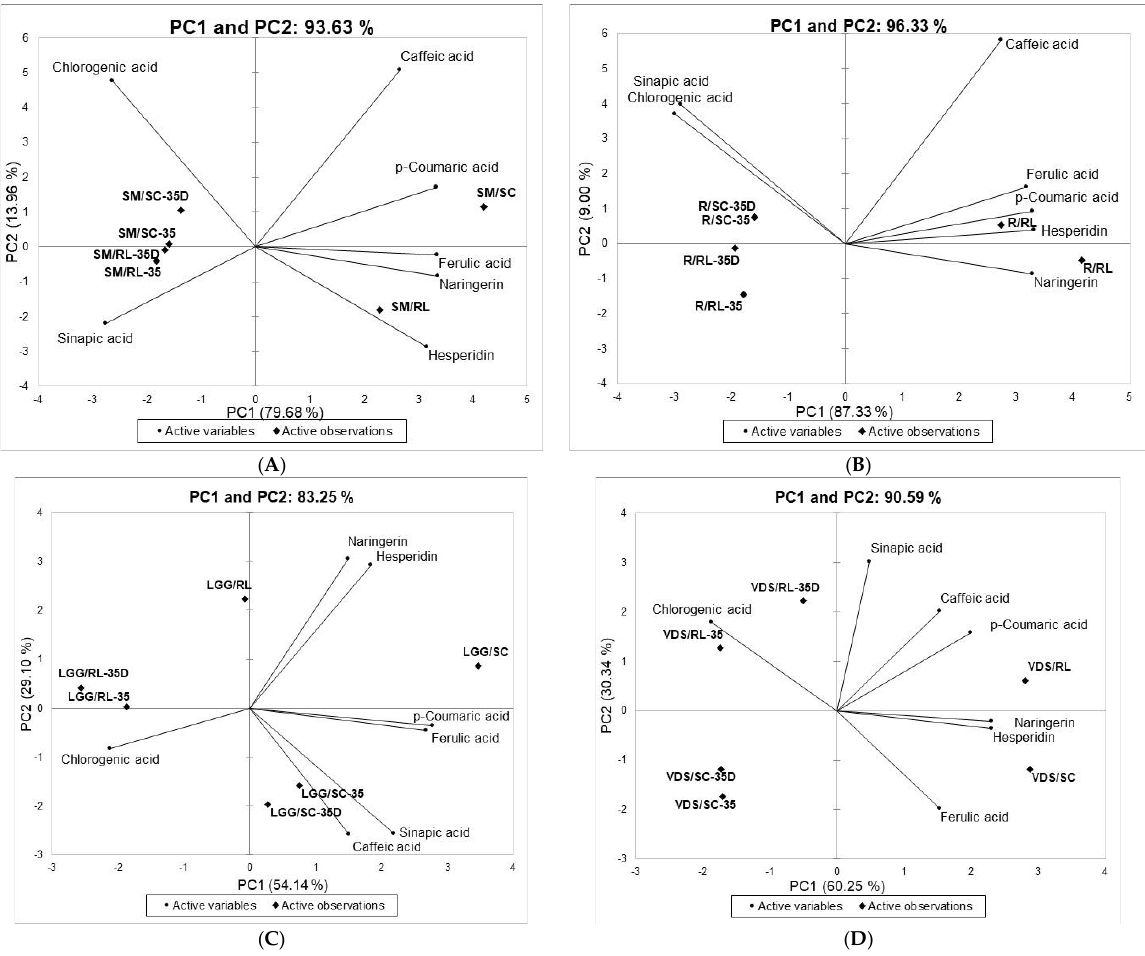
Figure 5. Principal component analysis (PCA) of phenolic compounds in juices from different scion/rootstock combinations subjected to 35 days of storage. ( A ) SM — Sanguínea de Mombuca; ( B ) R — Rubi; ( C ) LGG — Lue Gin Gong; ( D ) VDS — Valencia Delta Seedless; RL —‘ Rangpur ’ lime; CS —‘ Swingle ’ citrumelo; 0 = juice at the time of fruit extraction, 35 = juices stored for 35 days in transparent bottles; 35D = juices stored for 35 days in dark bottles.